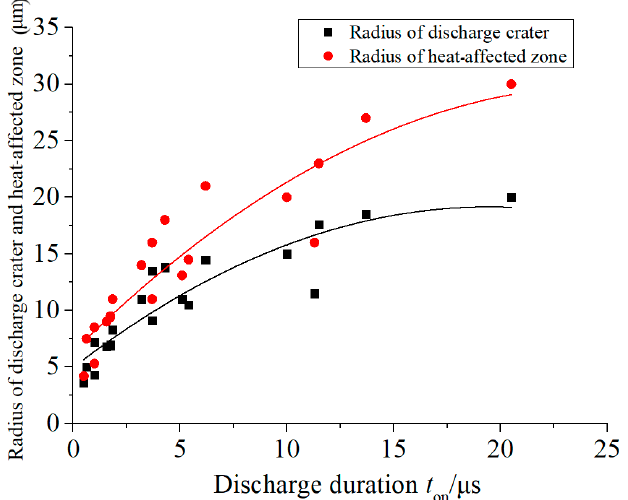
Figure 6. E ff ect of discharge duration on discharge crater and heat-a ff ected zone Figure 6. Effect of discharge duration on discharge crater and heat-affected zone radius.